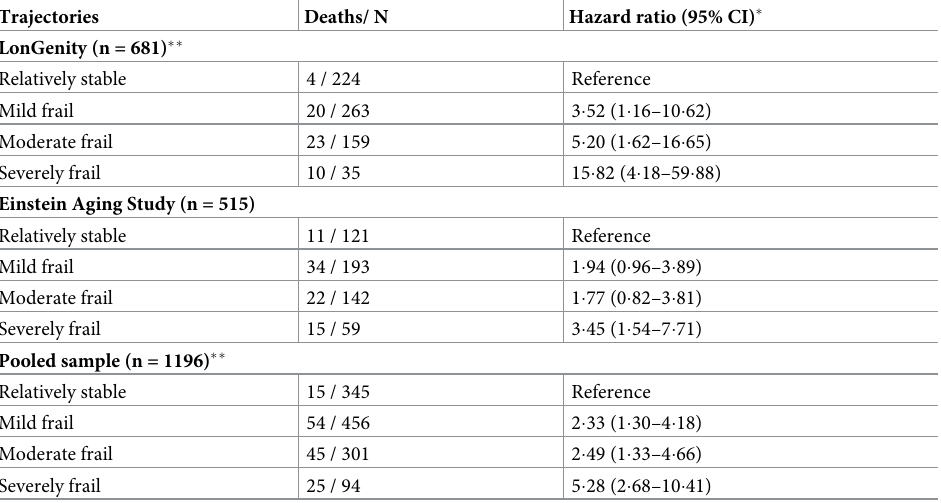
Table 3. Frailty trajectories and mortality risk in LonGenity, Einstein Aging Study and pooled sample.